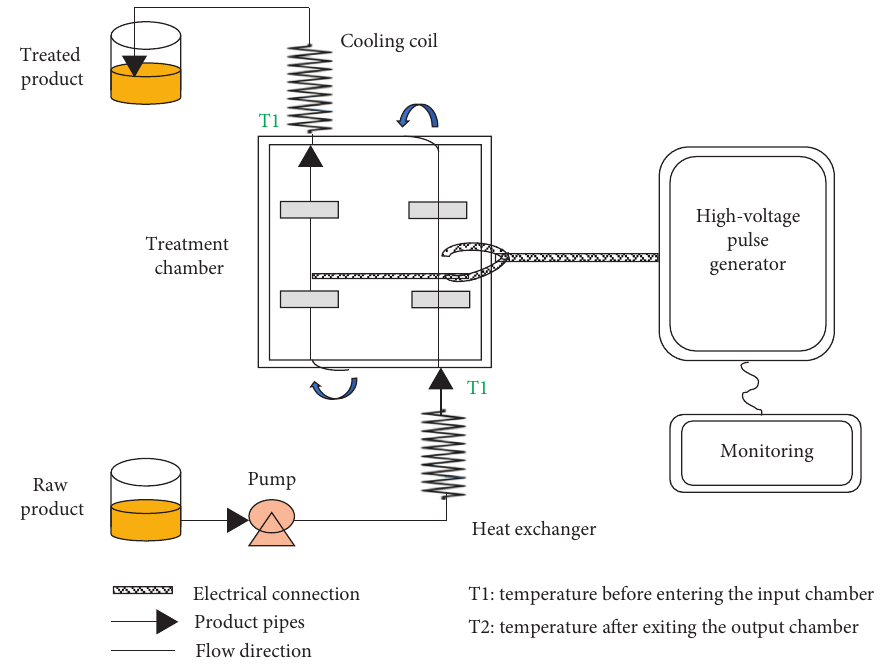
Figure 11: General scheme of a PEF equipment